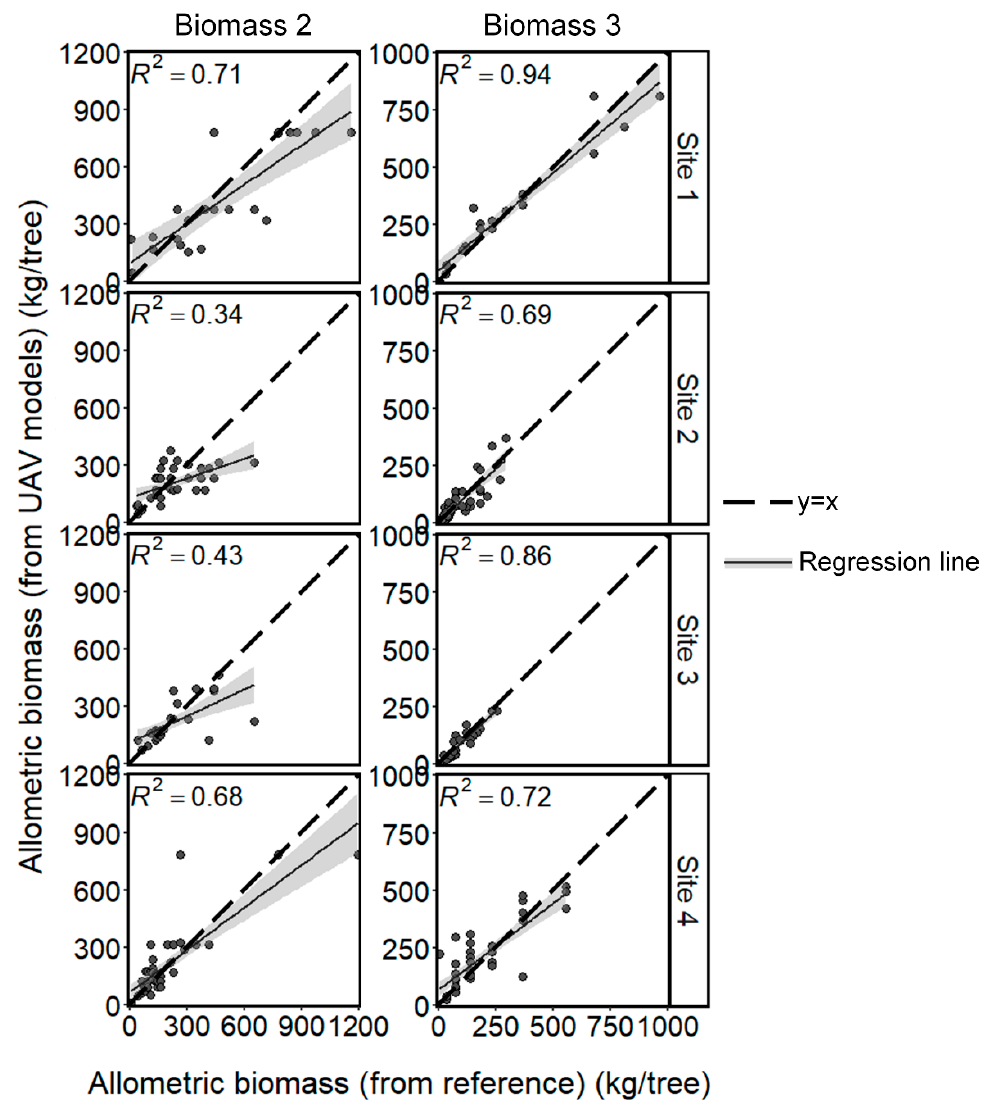
Figure A6. Site-specific AGB values obtained from allometric equations on variables measured by UAV (vertical axis) and reference values (horizontal axis) in high stands in Zone 3.